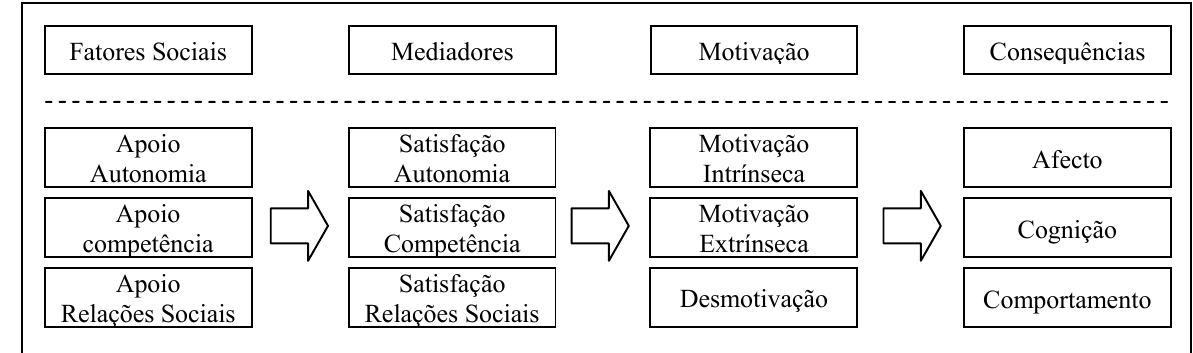
Figura 1 . Modelo Hierárquico da Motivação (adaptado de Vallerand, 2007).